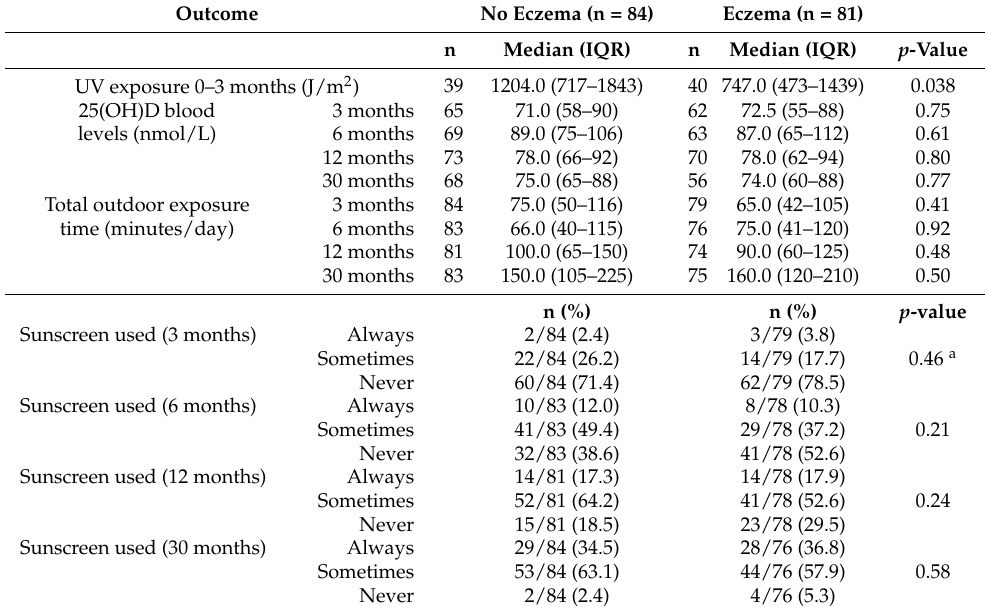
Figure 1. The influence of direct UV light exposure on allergy outcome. Table 2. Comparison of cumulative eczema outcomes by 2.5 years of age in association to examined key risk